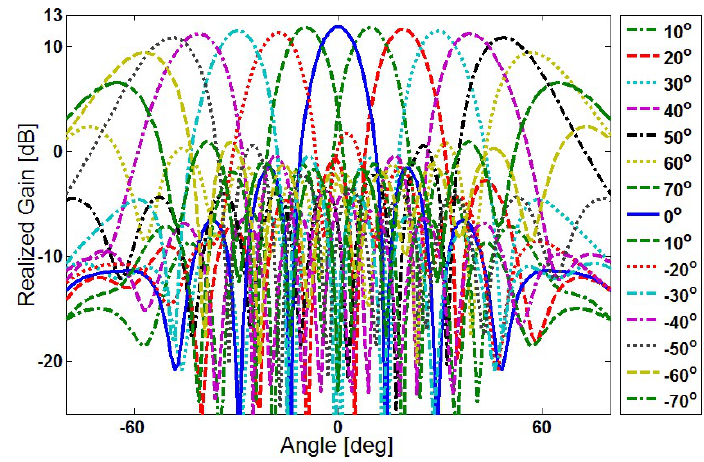
Figure 10. Array gain levels for the scanning radiation beams.